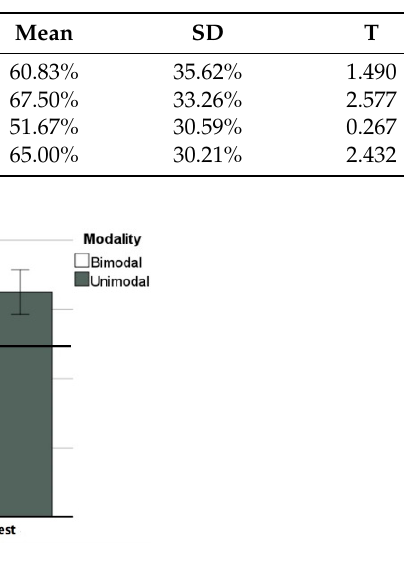
Table 1. Mean (SD) accuracy percentage and corresponding t and p values in one-sample t-test against the chance level in bimodal and unimodal before and after distributional learning in the discrimination task. (See Supplementary Material C for descriptive statistics of other contrasts.).